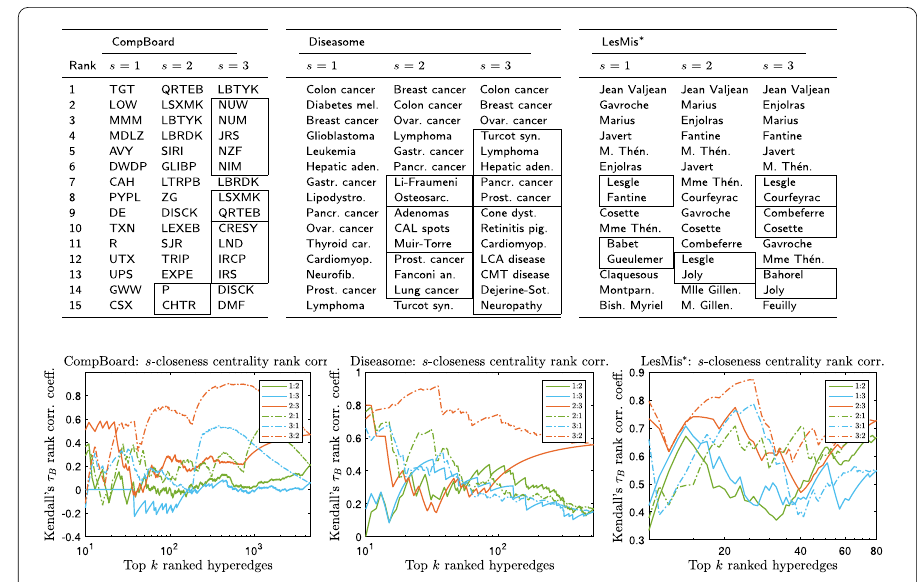
Figure 6 Toprow : top 15 ranked hyperedges for s = 1,2,3 in CompBoard, Diseasome, and LesMis * . Boxes enclosing items in the table indicate those hyperedges are tied in rank. Bottomrow : Kendall’s τ B rank correlation coefficient between the top k ranked hyperedges for a value of s (listed first in the legend) compared against those hyperedge’s ranking under a different value of s (listed